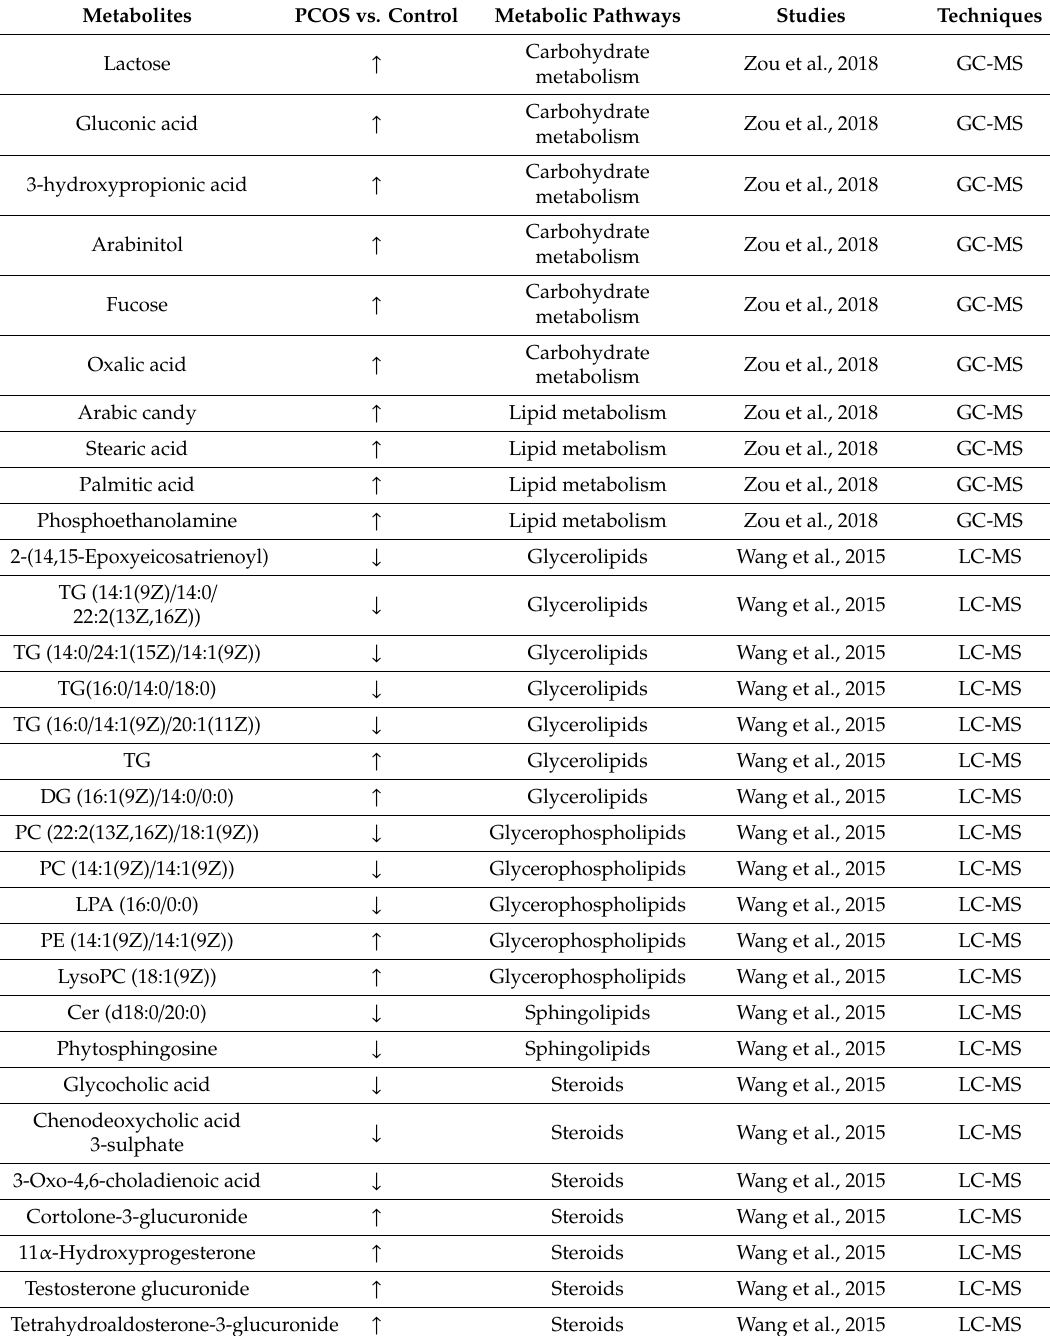
Table 2. The most significant changes in urinary metabolites in women with PCOS in comparison with the control